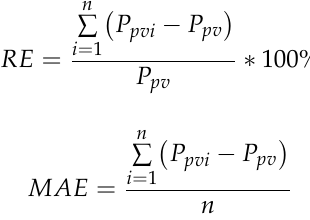
Figure 21. GRNN-OPA tracked power.